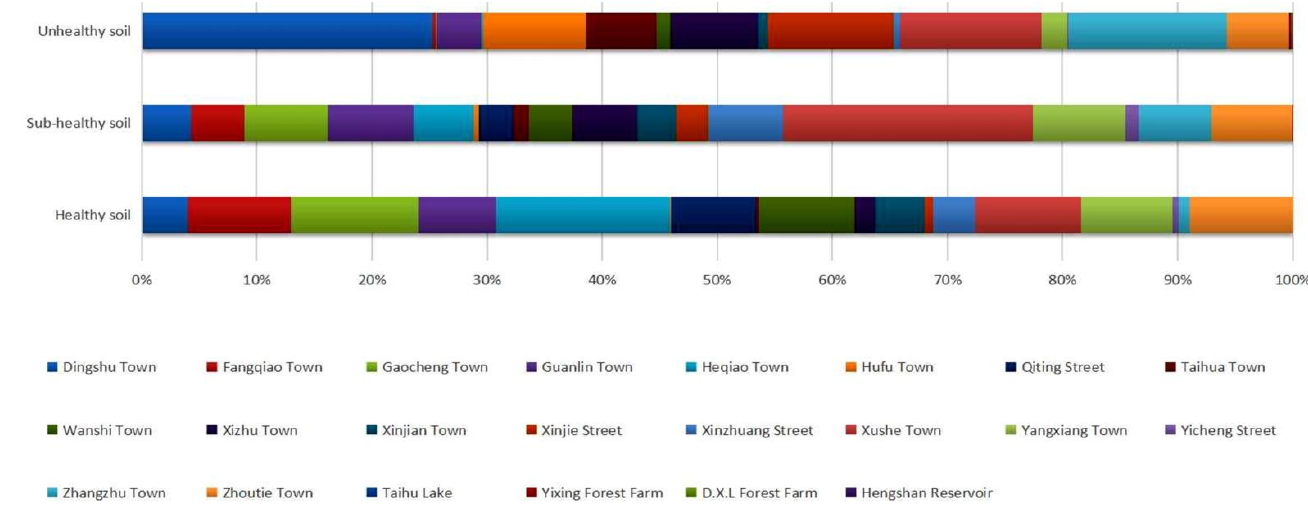
Figure 5. Comparison map of township distribution with different SH levels in Yixing City.